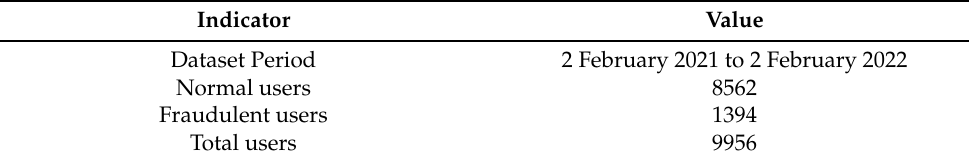
Table 1. Dataset